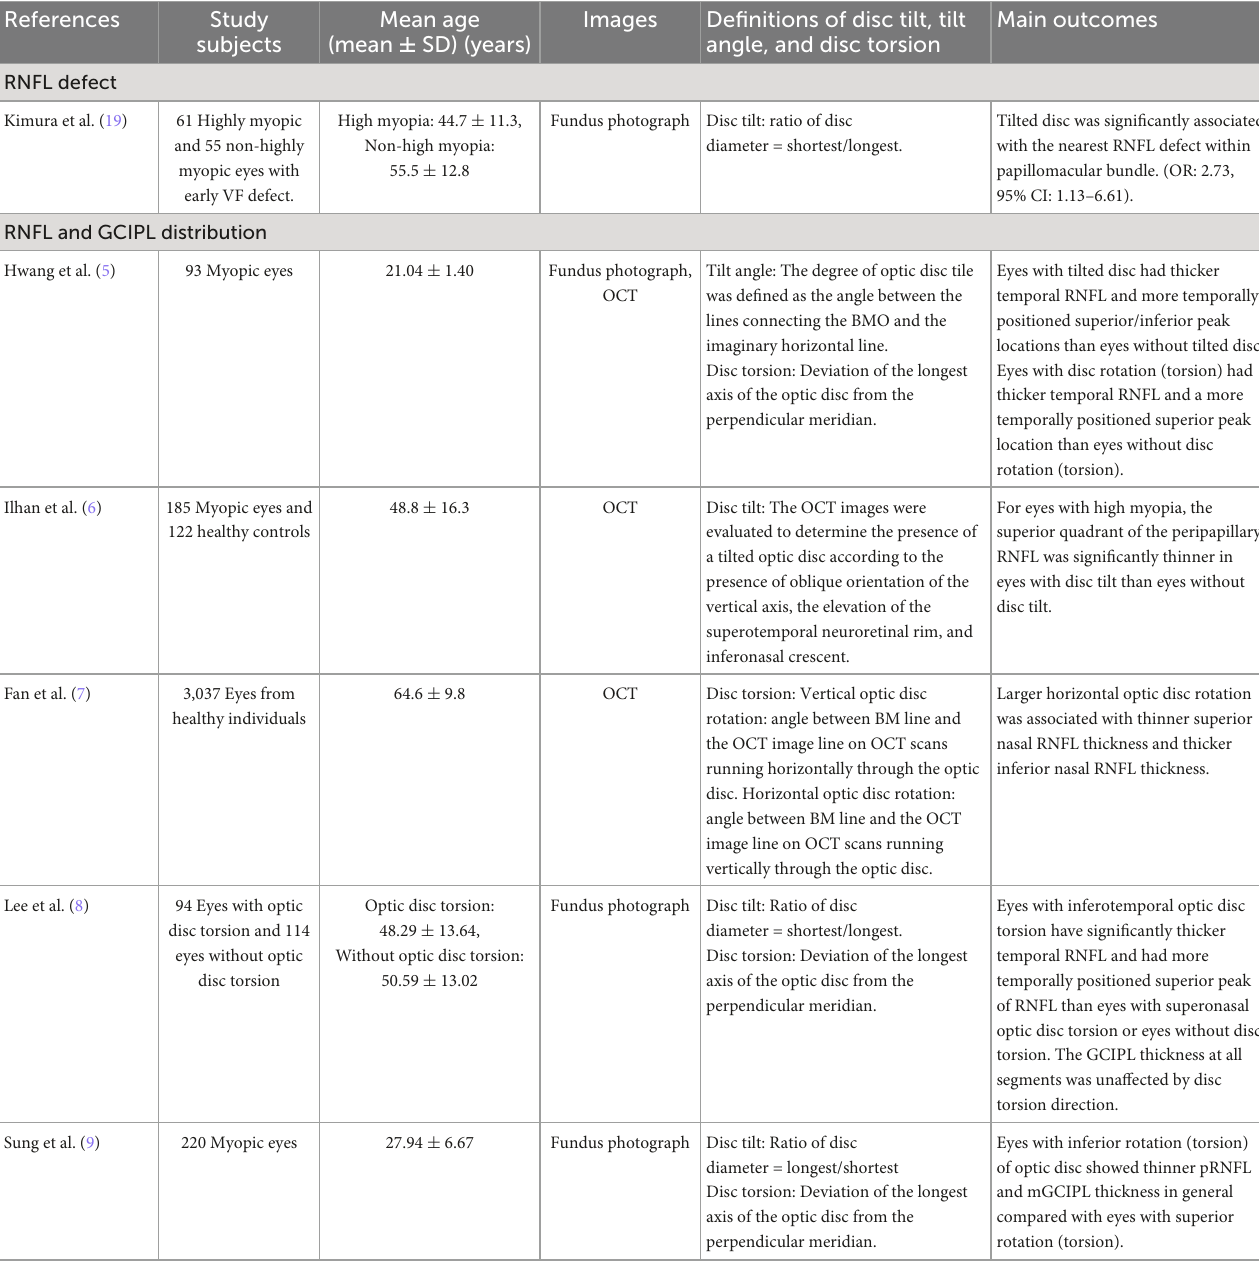
TABLE 2A Change of retinal nerve fiber layer and ganglion cell inner-plexiform layer in related to myopic tilted disc in myopic